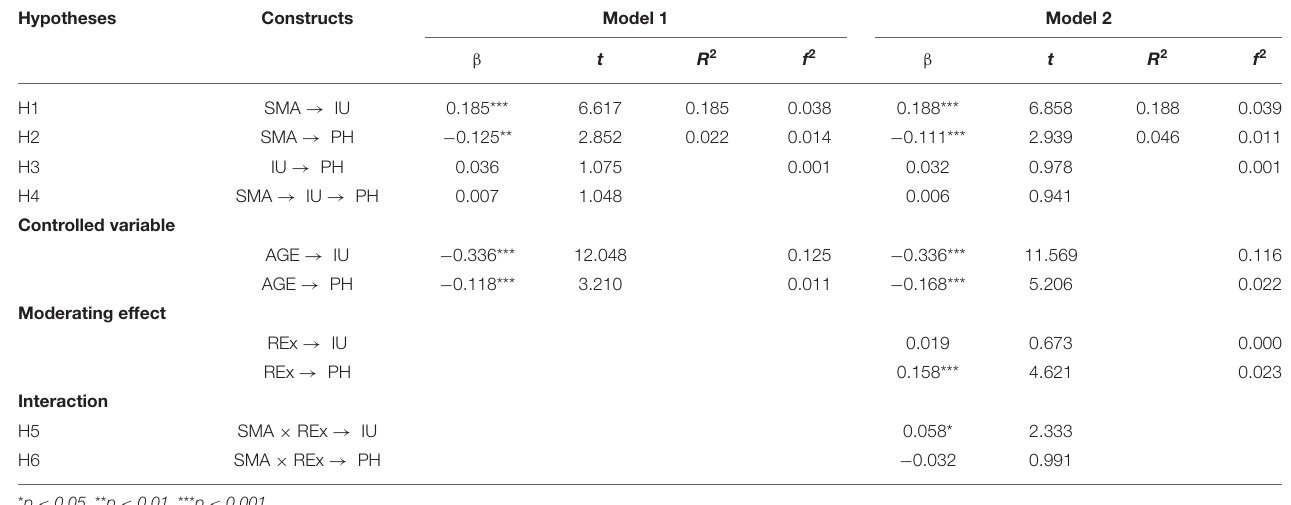
TABLE 6 | Overall structural model parameter estimation table.